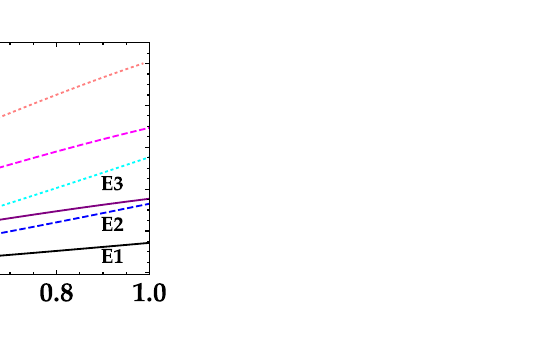
Figure 8. Noise reduction factor measured by Eve as a function of the transmittance efficiency t in the case of the higher mean value (black curve) and of the lower mean value (red curve). The quantum efficiency η is 1 represents the boundary between classical and nonclassical set equal to 0.2. The horizontal gray line at R = t ∗ , that is the threshold value over which Bob measures R > 1 . correlations. The vertical line corresponds to t =